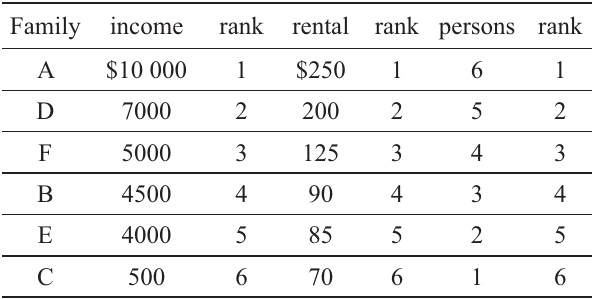
Table B.2. Rank order of families by income,